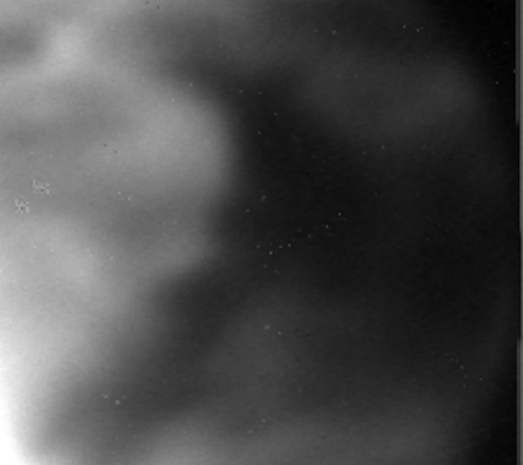
Figure 8. Evidence of a major cloud discontinuity on the lower cloud layer of Venus ( ∼ 48 km of altitude) detected on the 12 July 2012, in our ground-based observations obtained in the near-infrared (2.28 µ m K continuum filter) with the Telescope Galileo and the near-infrared camera NICS in La Palma observatory. This disruption in the clouds spread between ∼ 40 ◦ latitude in both hemispheres and is seen as a huge dark band, almost at planetary scale.